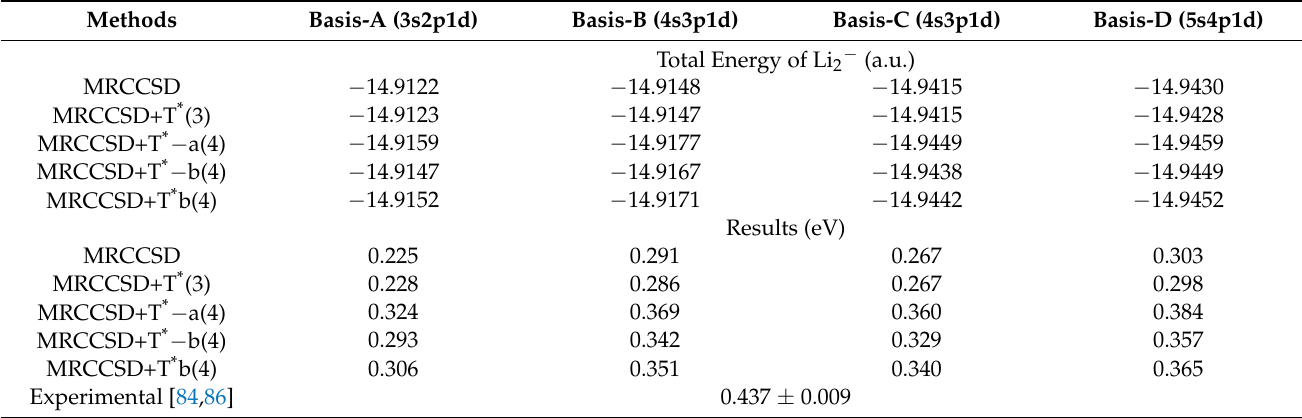
Table 5. Total energy of Li − in a.u.and adiabatic electron affinity of Li 2 in eV using various basis sets at inter-nuclear 2 separation of 6.0 a.